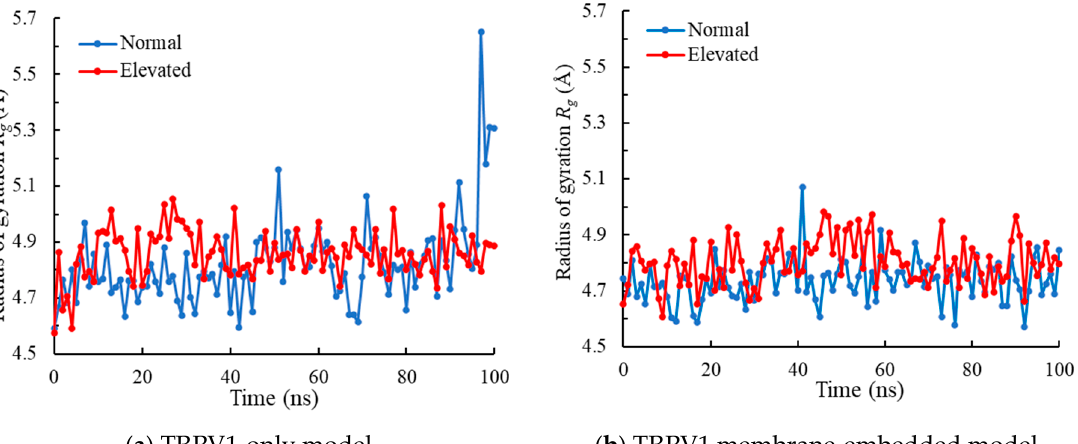
Figure 3. The radius of gyration R g at the lower gate of ( a ) TRPV1-only model and ( b ) TRPV1 membrane-embedded model.